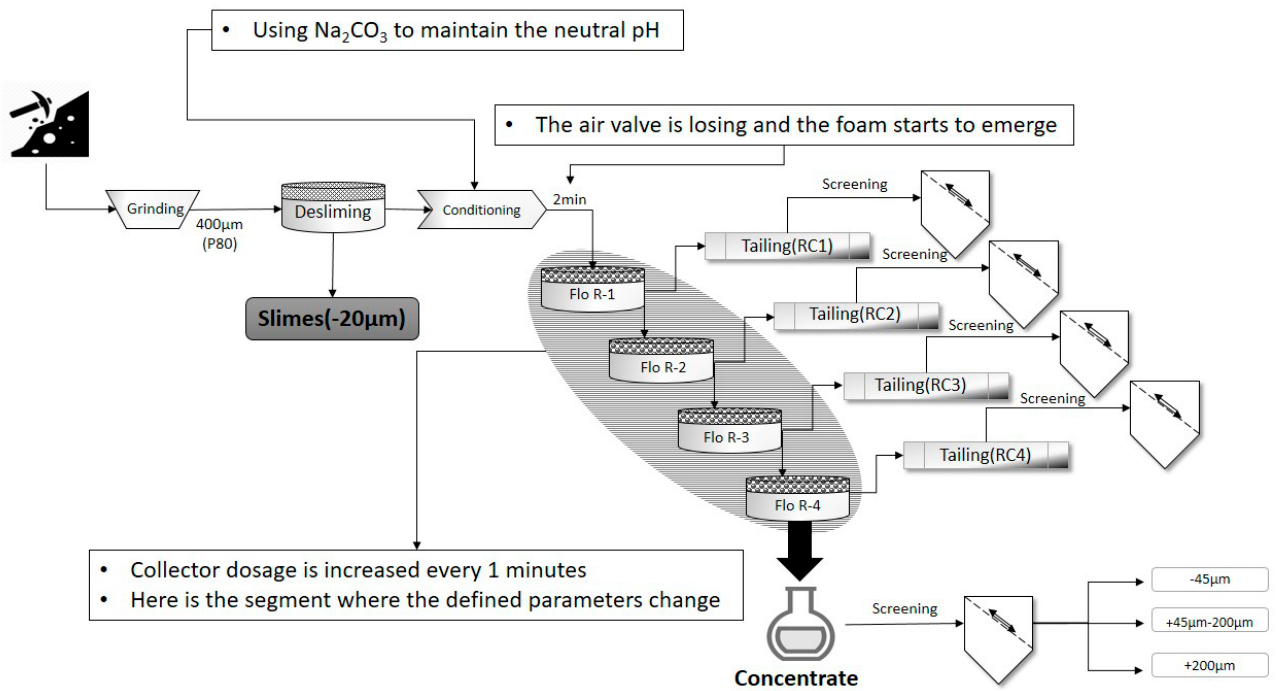
Figure 1. Experimental Design to study the Estonian phosphate rock optimum flotation process (Phase 1).